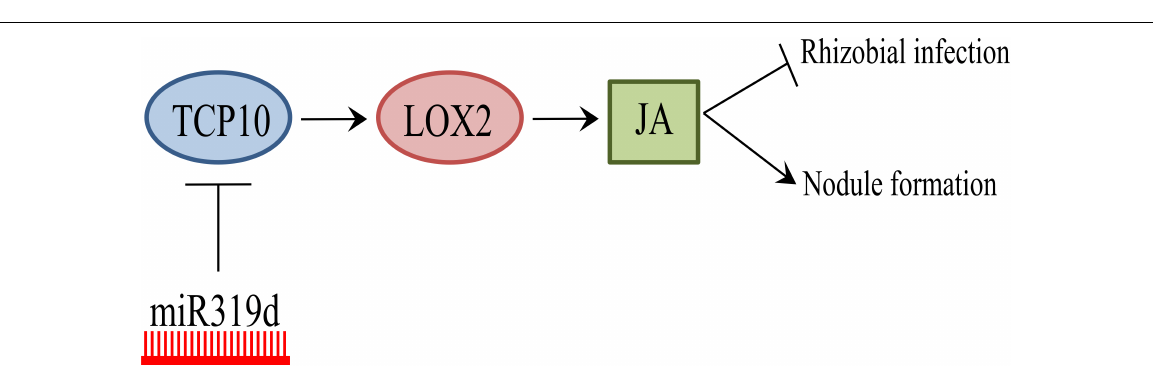
FIGURE 6 | Effect of the modulation of miR319d/TCP10 expression in JA-biosynthetic and JA-responsive genes expression. Transgenic hairy roots from OE319d (black histograms), EV (white histograms) and STTM319 (gray histograms) rhizobia-inoculated plants were collected at 2 and 24 dpi and total RNA was isolated for qRT-PCR analysis. Expression analysis of the JA-biosynthetic genes LOX2 , LOX5 (A) and AOS2 and of the JA-responsive gene MC (B) . Values were normalized to the values of the EV-transformed control plants that was set to one. Values represent means ± SD from three biological replicates and two technical replicates each. The Mann–Whitney null hypothesis statistical test is relative to EV control data ( ∗ and ∗∗ represent a p- value < 0.05 and p- value < 0.01, respectively).